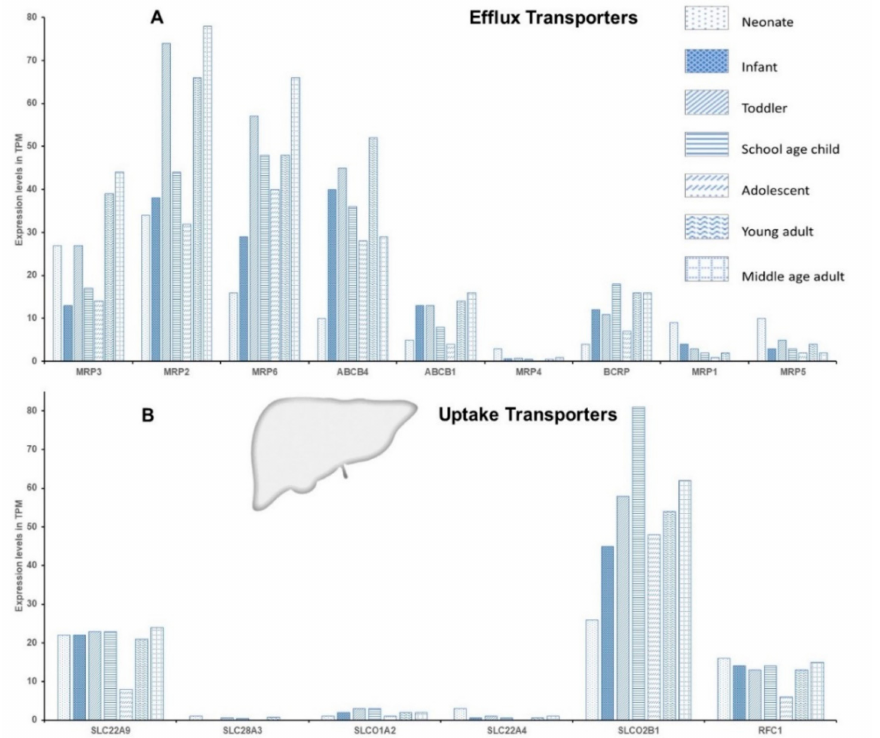
Figure 3. The mRNA expression of some of the key hepatic efflux ( A ) and uptake ( B ) transporters. The y -axis denotes expression levels in transcript per million (TPM). The data were collated and adopted from EMBL-EBI Available online: https://www.ebi.ac.uk/gxa/home (accessed on 27 June 2022) [28].